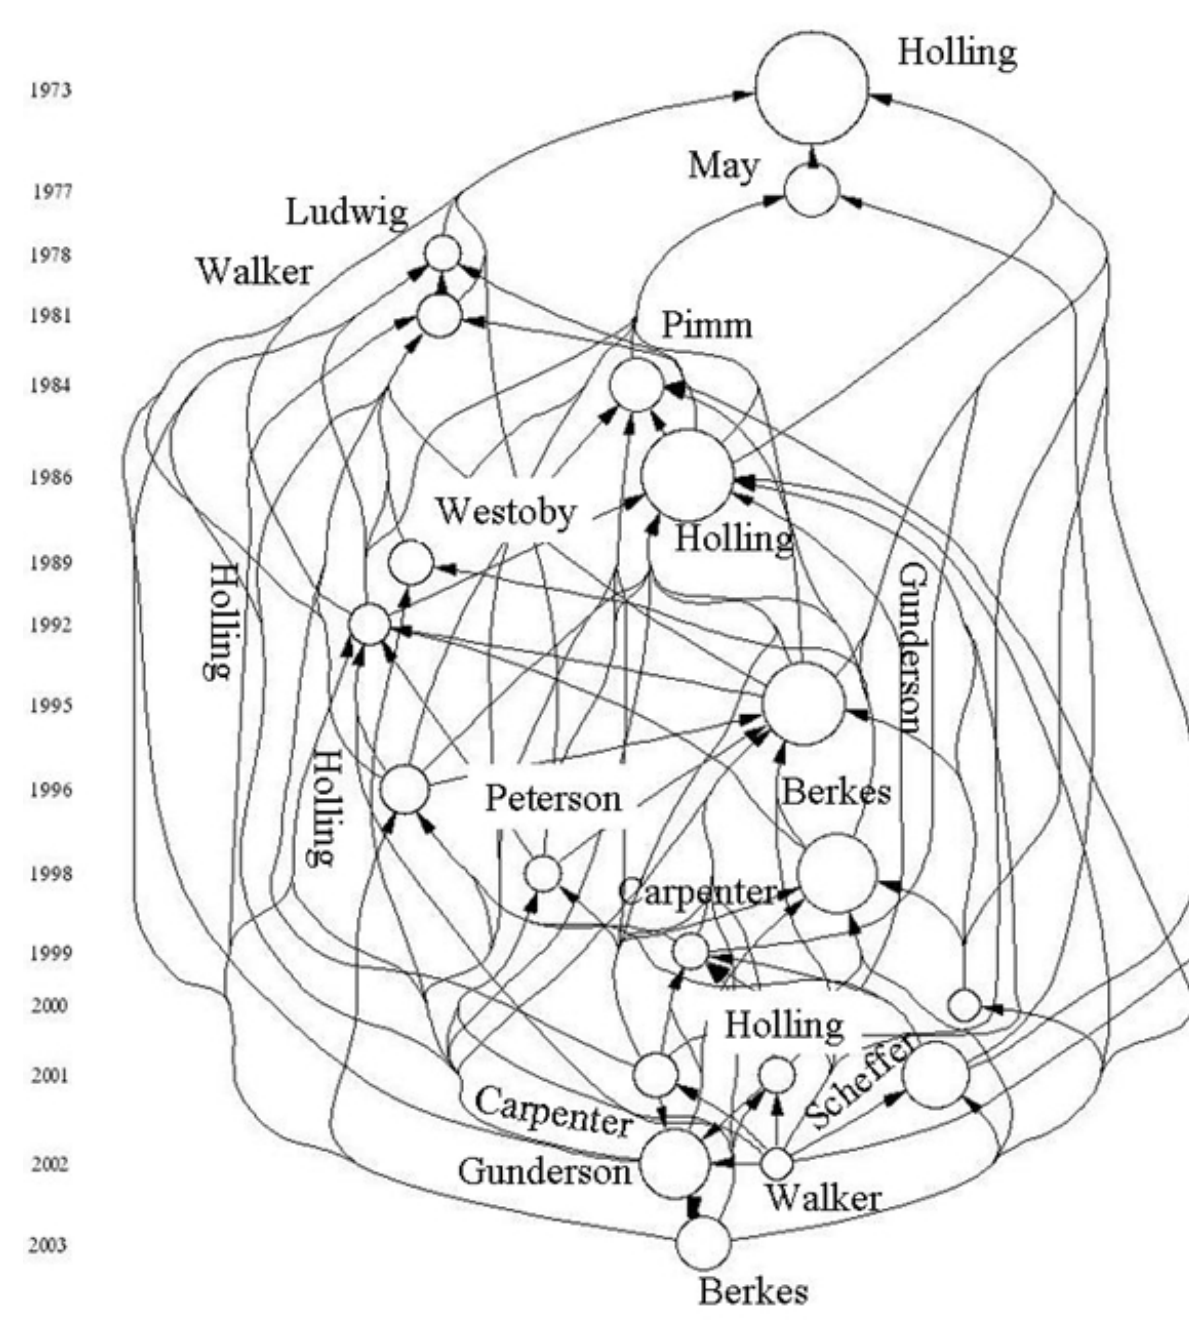
Fig. 4. Paper citation network of the most highly cited papers within the resilience knowledge domain (Threshold 40 citations within the data set). The node size denotes the number of citations, the arrows refer to